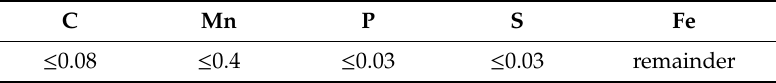
Table 1. Chemical composition of DC04 steel sheet (in